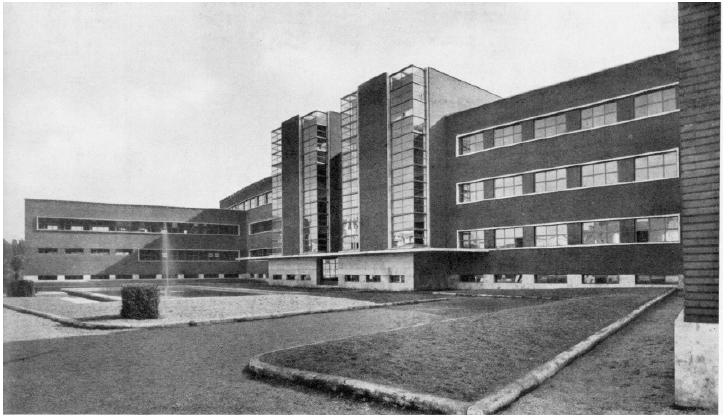
Figure 29. The Institute of Botany by Giuseppe Capponi. Photo from (Baliviera et al. 1935, p. 65).